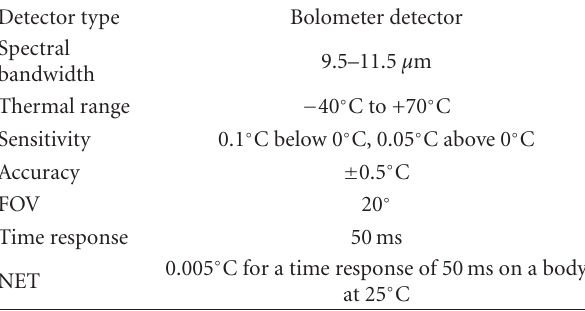
Table 1: Characteristics of PRT5